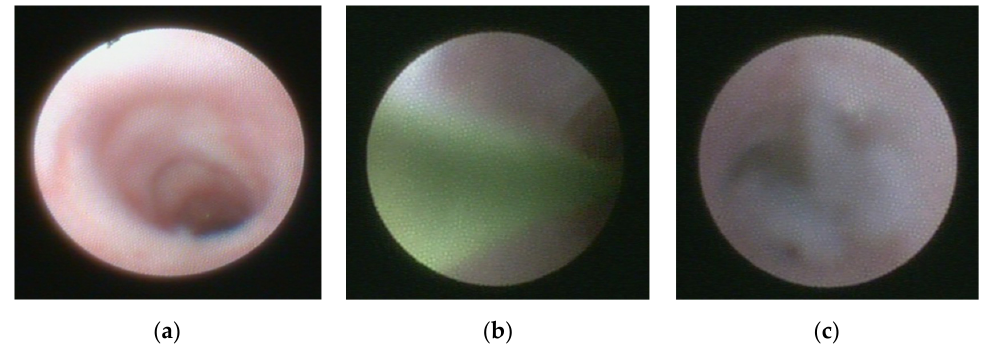
Figure 2. Sialendoscopic appearance of the parotid duct. ( a ) displays the endoscopic appearance of pale mucosa. ( b ) depicts guiding wire introduced during the sialendoscopic procedure to overpass the stenosis. ( c ) shows mucus in the main salivary duct. The patients who underwent local anaesthesia were discharged the same day, while those who had the procedure under general anaesthesia were discharged the following day. Thus, the mean hospital stay was 0.86 days. The antibiotics were administrated to all patients—twenty patients (95%) received amoxicillin with clavulanic acid, and one was given clindamycin due to penicillin allergy. None of the patients had problems with re-